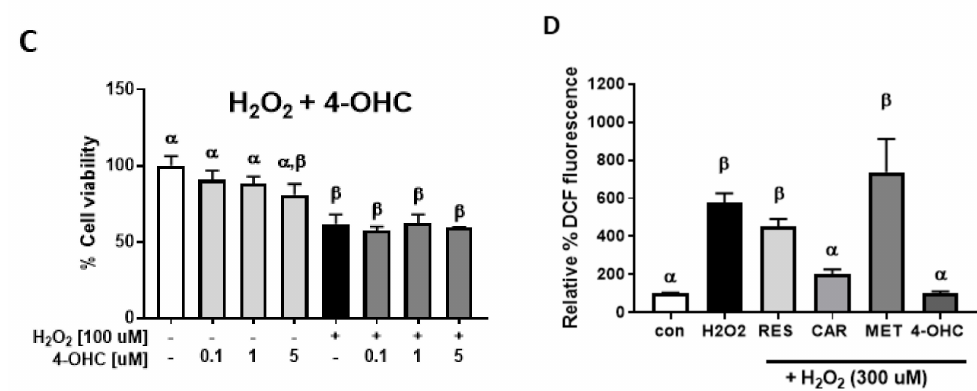
Figure 2. E ff ect of carvedilol, metoprolol, and 4-OHC on H 2 O 2 -induced reduction of cell viability and formation of ROS in JB6 P + mouse epidermal cells. The cells were treated with H 2 O 2 at the concentration of 100 µ M. The cells were treated with indicated concentrations of CAR ( A ), MET ( B ) or 4-OHC ( C ) for two hours before H 2 O 2 treatment and incubated with the drug and H 2 O 2 for an additional 24 h before the quantification of viable cells using Trypan blue assay. Data presented are the mean +/ − SD of 3~6 independent experiments. The number of viable cells was normalized as the percentage of vehicle control. ( D ) The cells were treated with resveratrol (RES) (50 µ M, positive control), carvedilol, metoprolol, or 4-OHC (10 µ M each) for two hours and then loaded with PBS containing 10 µ M H2-DCF-DA for 30 min. The cells were then treated with 300 uM of H 2 O 2 for 30 min. The DCF fluorescence levels were determined using flow cytometry. Each bar represents the mean +/ − SE ( n = 3). The bars with a di ff erent letter are significantly di ff erent from each other at the level of P <